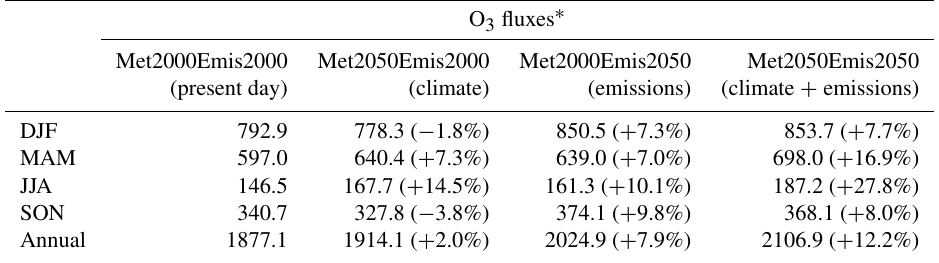
Table 5. Simulated present-day O 3 fluxes and projected changes from the present day (1996–2005) to the future (2046–2055) through the vertical plane along 135 ◦ E from 20 to 55 ◦ N and from the surface to 100hPa due to future climate change alone, changes in anthropogenic emissions alone, and changes in both climate and